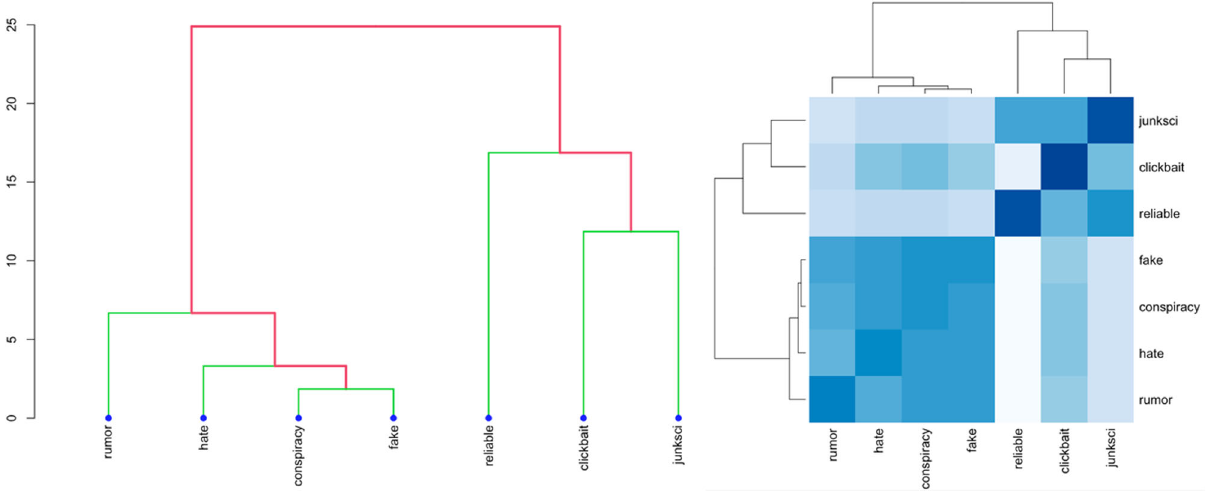
Fig. 2 Cluster similarities. Hierarchical clustering of categories. A red lines indicate stronger associations. B darker colors indicate stronger